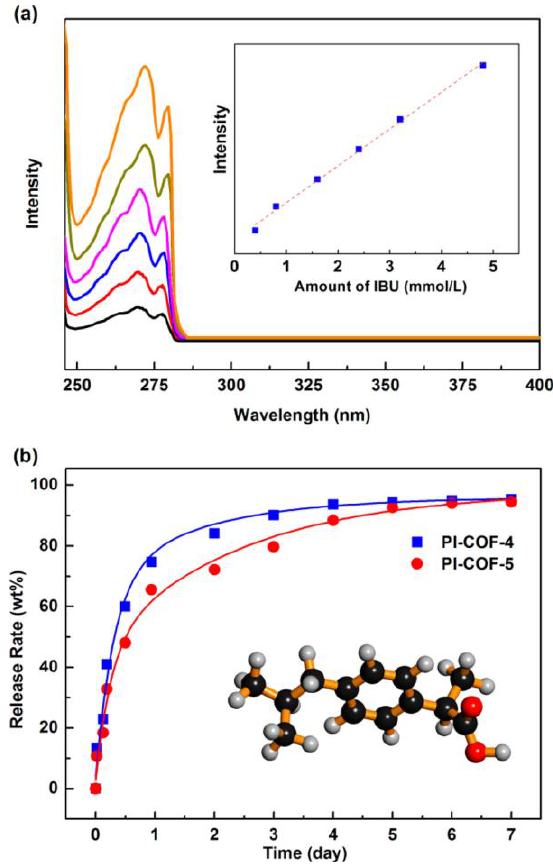
Figure 12. ( a , b ) PI-COFs with high surface areas for drug delivery. Reprinted (adapted) with permission from [47]. Copyright {2015} American Chemical Society.